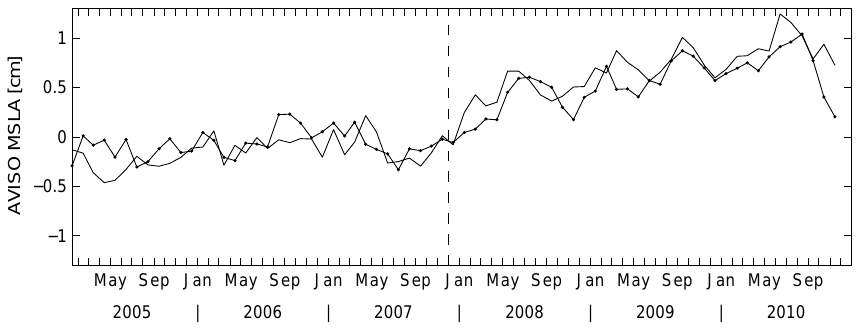
Fig. 4. Testing the method using gridded altimeter MSLA measurements (AVISO): gridded MSLA during 2005–2010 are subsampled to Argo profile positions and the simple box averaging method was applied. Global MSLA derived from the AVISO grid (bold line) is compared to its corresponding subsampled result (bold+dots). Dashed line marks November 2007, i.e. when initial Argo sampling was almost achieved.